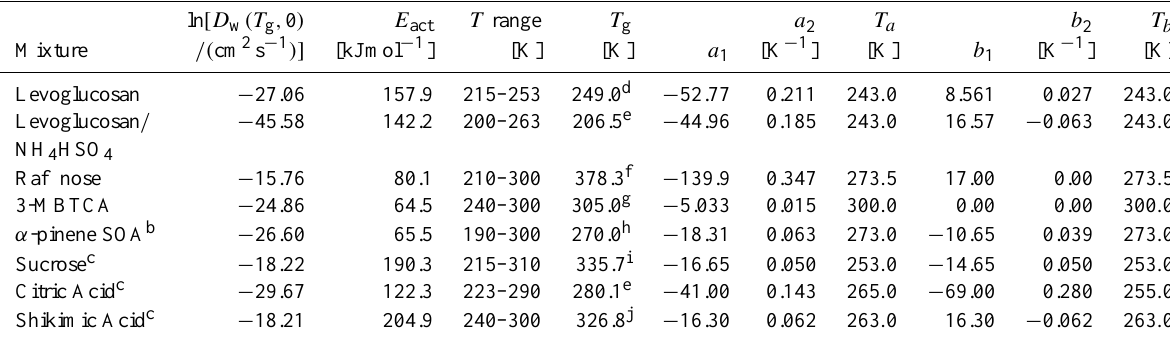
Figure A1. Same as Fig. 4 in the main text but for organic aerosol particles experiencing adiabatic updrafts starting at 40% RH and 228K with linear updraft velocities of 0.1, 1 and 3ms − 1 . Table A1. Fit parameters for Eqs. (A4) and (A6) a